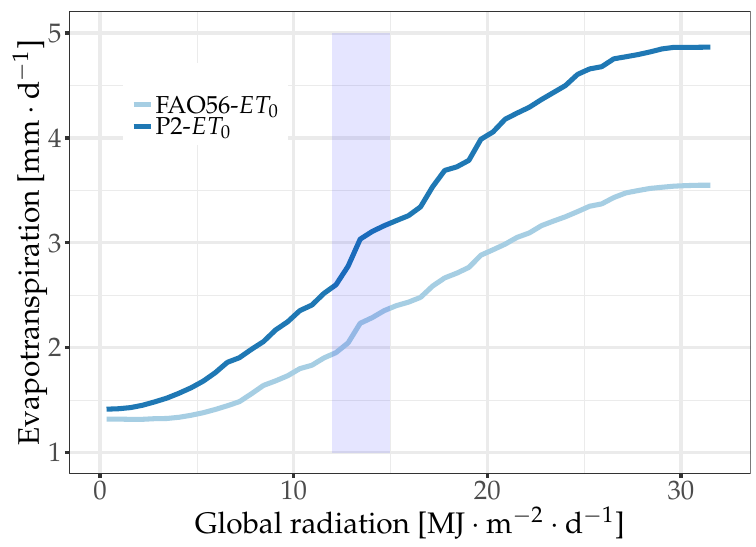
Figure 4. ET 0 (mm d − 1 ) predicted by global radiation (MJ · forest models for P2- ET 0 and FAO56- ET 0 . The shaded box marks a similar the sudden rise of both ET 0 s in response to the global